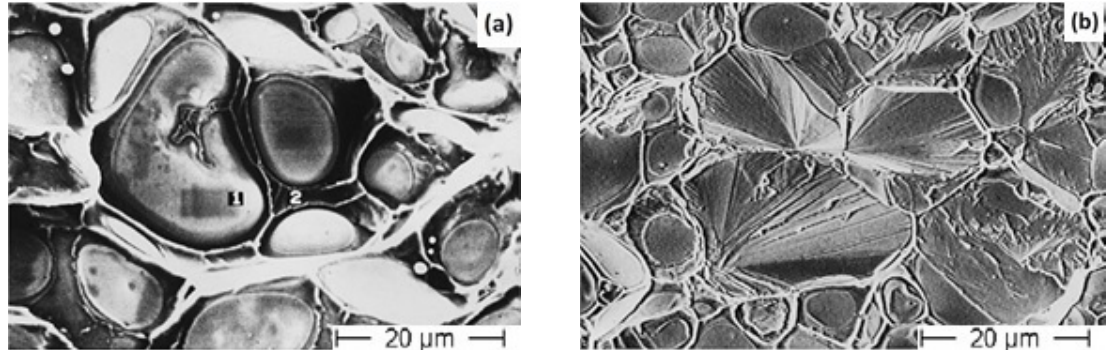
Figure 7. Fracture surfaces of the W–Ni–Fe-Mo alloy ( a ) without La and ( b ) with 0.4% La [71]. Reproduced with permission from Wu et al., International Journal of Refractory Metals and Hard Materials; published by Elsevier, 1999.